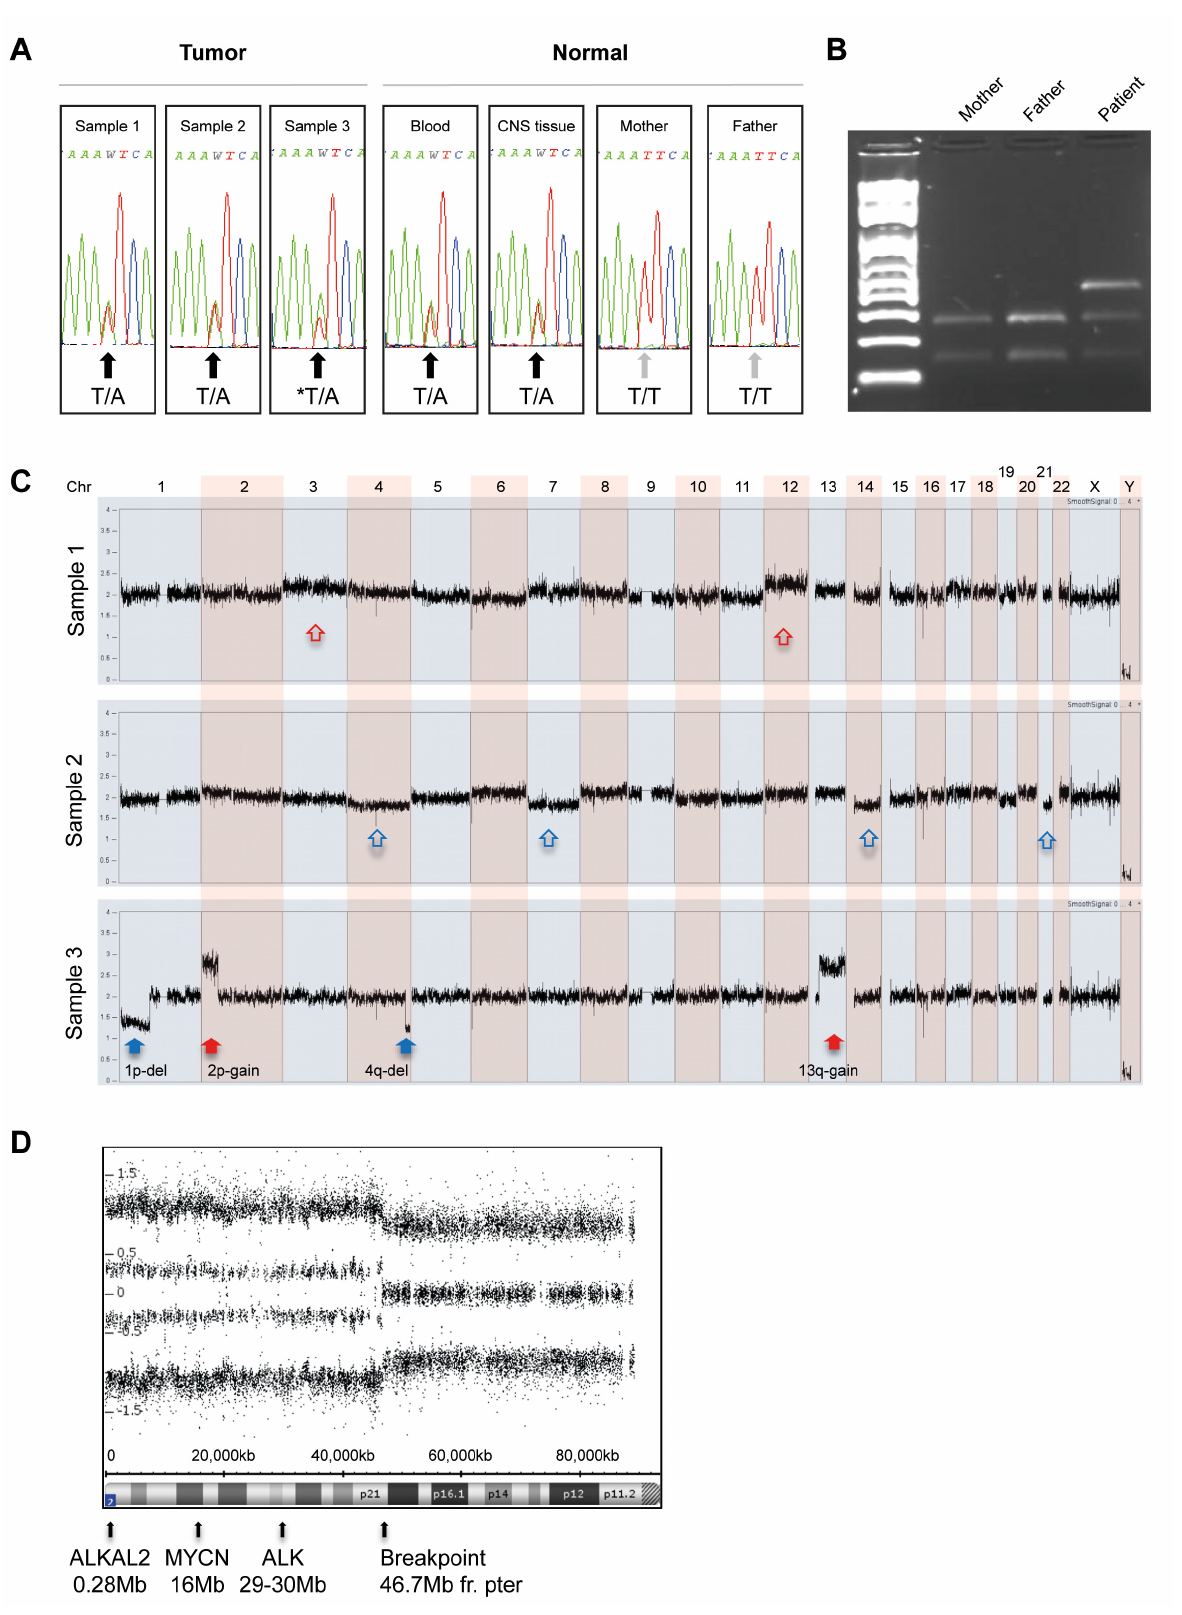
Figure 2. Molecular analysis of the ALK gene and genomic profiling with SNP arrays. ( A ) Electro- pherograms showing sequence covering the position corresponding to ALK F1174 in patient samples and parent samples. The heterozygote base substitution resulting in the ALK missense F1174I